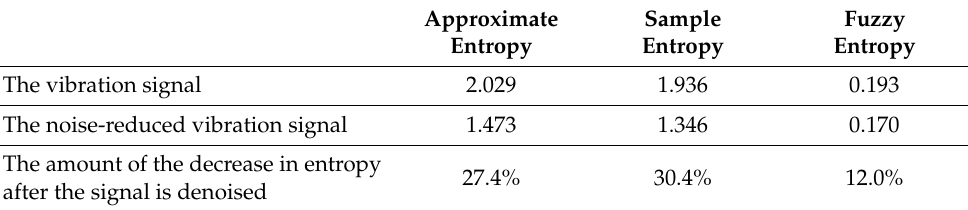
Figure 11. Waveform and envelope spectrum of vibration signal and noise-reduced vibration signal in Case 1. ( a ) Waveform of vibration signal and noise-reduced vibration signal; ( b ) Envelope spectrum of vibration signal; ( c ) Envelope spectrum of noise reduction signal. Table 1. Entropy values of vibration and noise reduction signal in Case